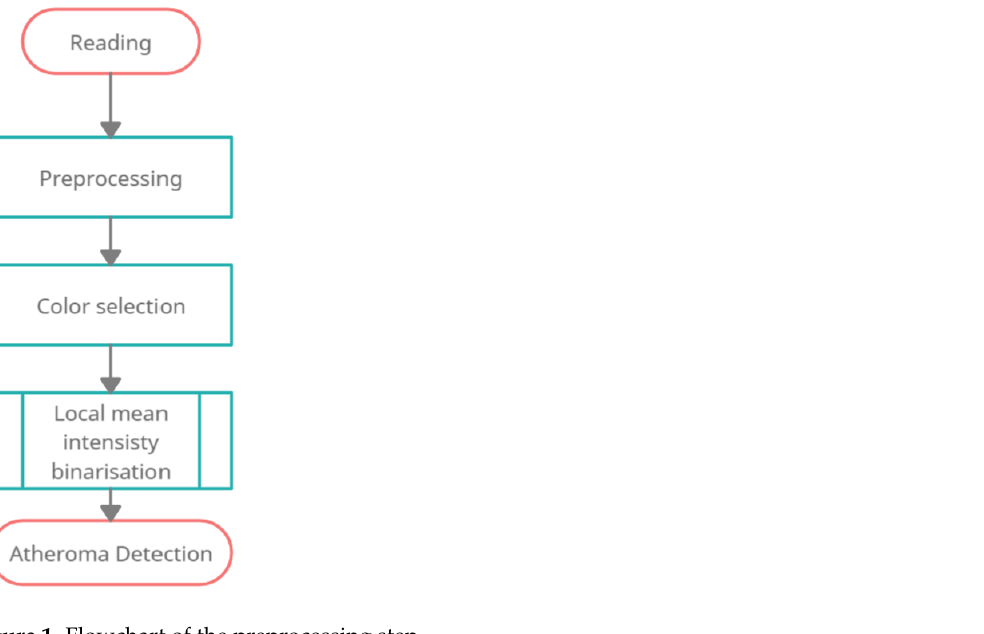
Figure 1. Flowchart of the preprocessing step.